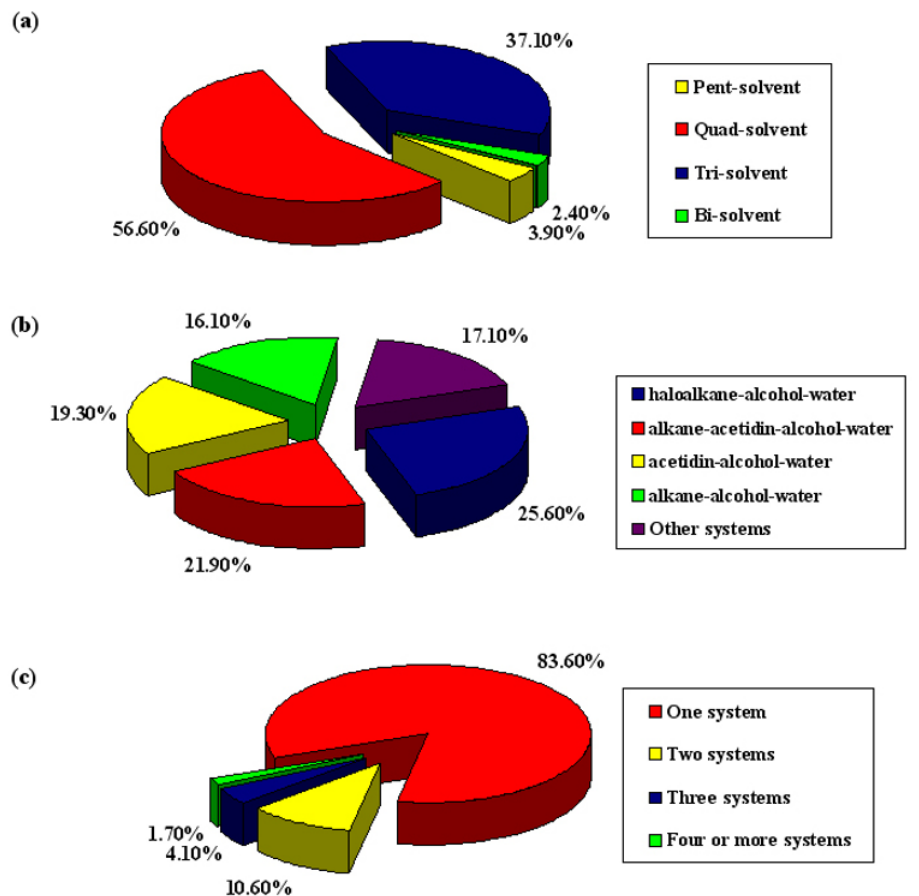
Figure 5. The percent data about the using condition of HSCCC solvent systems in study of natural